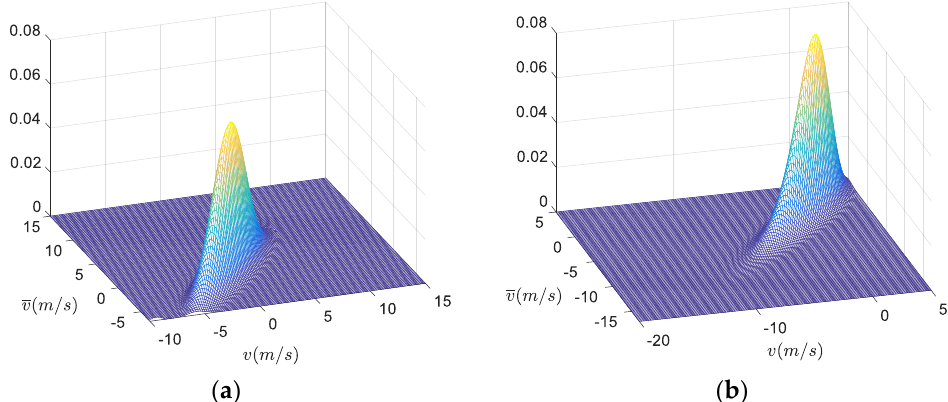
Figure 4. The distribution of function g ( v , v ) with different parameters s 1 , s 2 , and σ indicating different wind speed regions. These parameters are listed as: ( a ) s 1 = 9, s 2 = 4, and σ = 1; ( b ) s 1 = 21, s 2 = 11, and σ =